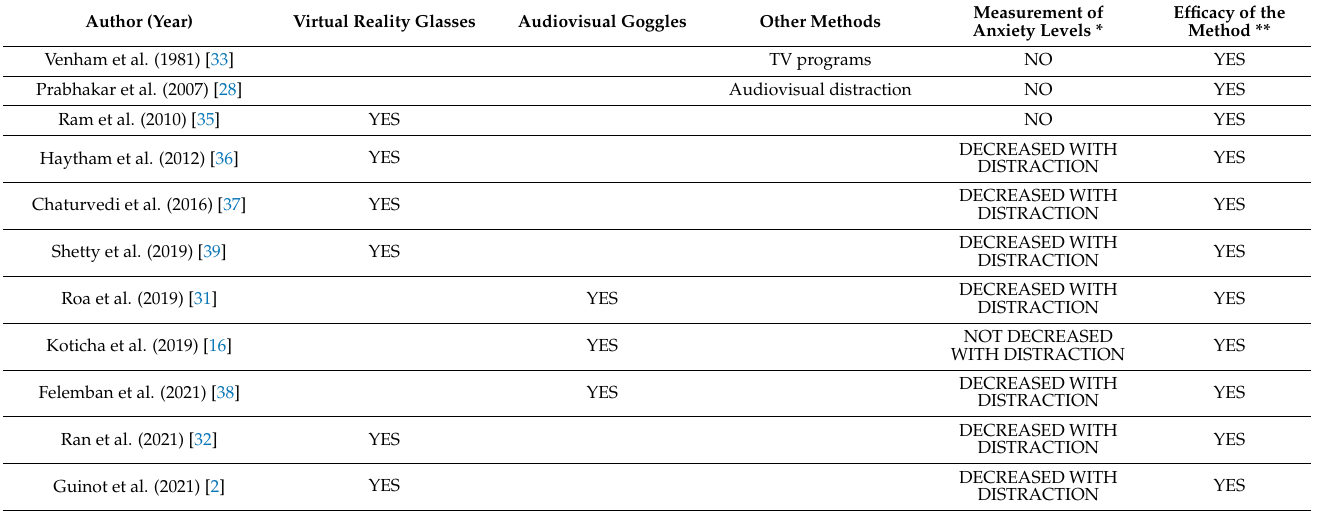
Table 1. Articles’ findings on anxiety and efficiency of VR glasses (* the measurements are statistically significant; ** efficacy measured as a decrease in